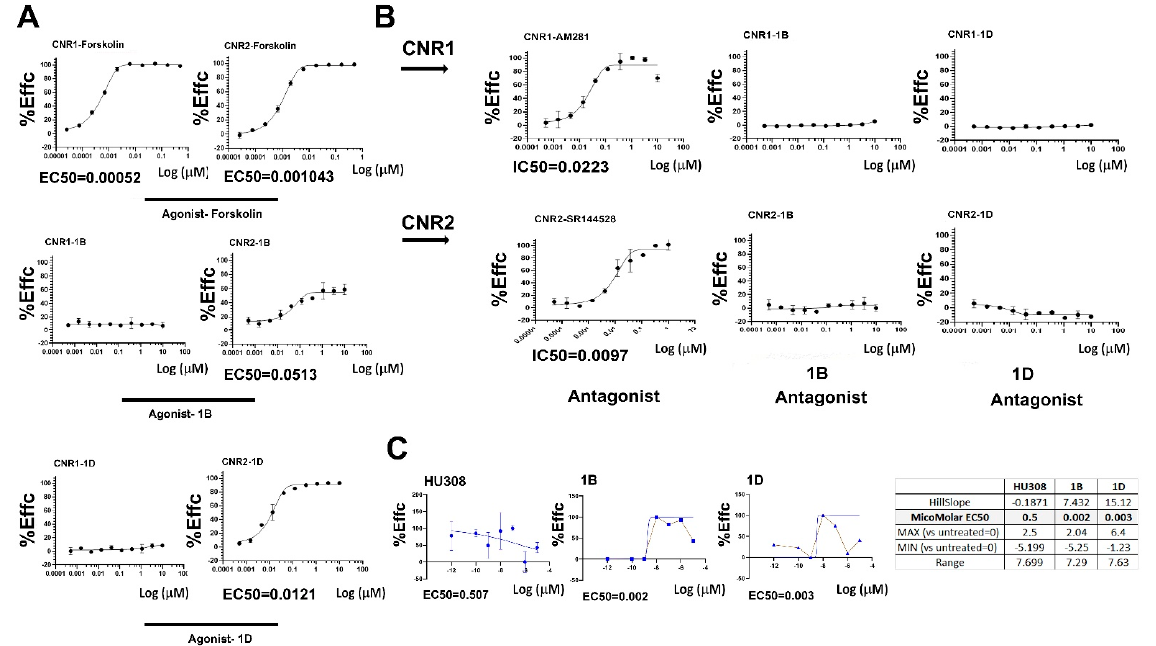
Figure 1. Fenchone 1D and 1B are selective agonists for CB2. ( A ) To test for agonist activity of GPCR cells expressing CNR1 or CNR2, cells were exposed to forskolin (positive agonist control), 1B and 1D fenchones, and assayed for EC50 values (µM), as in the Materials and Methods (SD1). X-axis display %Effc representing percent efficacy relative to the maximum response of the control ligand, while Y-axis display Log of μ M concentration of ligand. ( B ) Antagonistic activity was assessed after CP55940 agonist induction, using a range of antagonist concentrations (AM281 for CNR1 and SR144528 for CNR2), as well as 1D and 1B fenchone compounds (SD2). IC50 values are determined by the cAMP inhibition levels observed after antagonist stimuli. ( C ) Human OA-derived articular chondrocytes were plated at confluence and treated with HU308, 1D and 1B fenchones for 45 min and assessed for EC50 values. The values were obtained using GraphPad Prism EC50 curve fits which display the minimum and maximum ranges along with the Hillslope fit value.